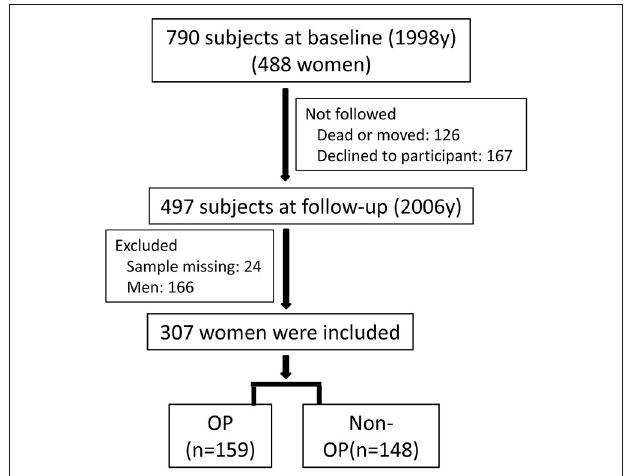
FIGURE 1 | The flowchart of subjects selection. Around 790 subjects (488 women) were included at baseline (1998), and 307 women were finally included at follow-up (2006).